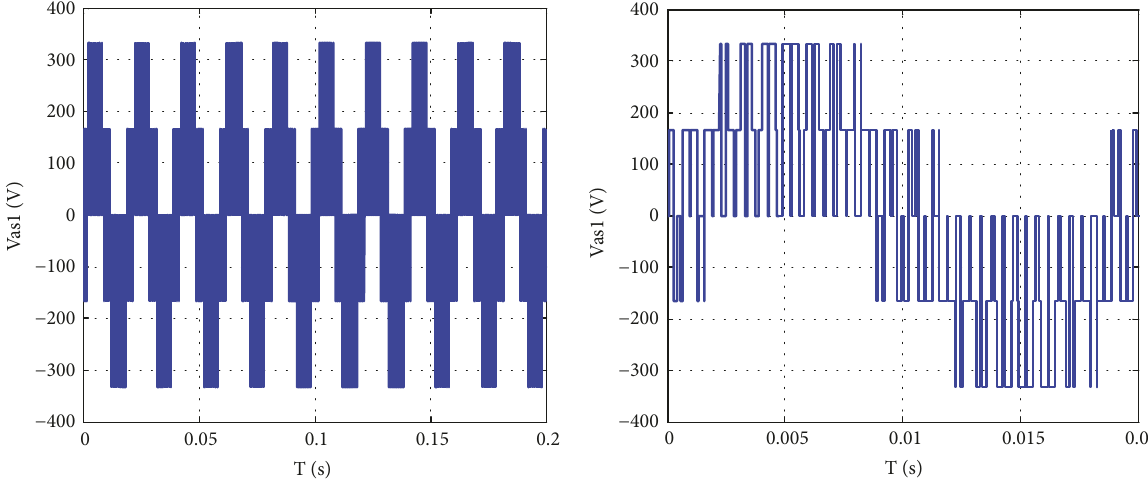
Figure 3: Waveform of output voltage 𝑉 𝑎𝑠1 for m=2.